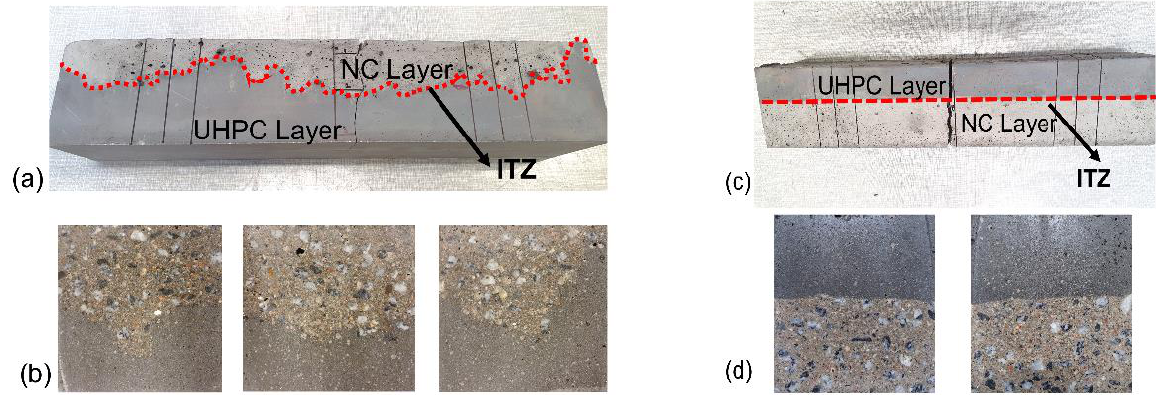
Figure 3. A horizontal layer of hybrid concrete casted in two different arrangements. ( a ) Fluid concrete in the bottom, ( b ) Cross section of the beam when fluid concrete in the bottom, ( c ) Fluid concrete on the top, ( d ) Cross section of the beam when fluid concrete is on top.